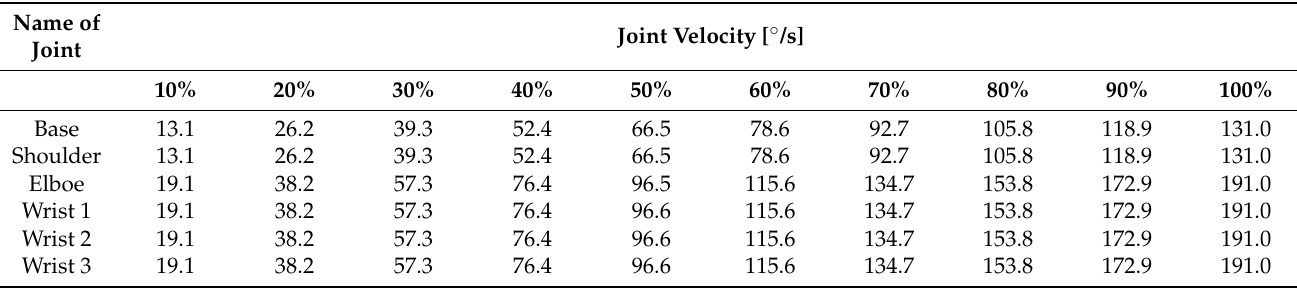
Table 1. Percentage velocities from maximum velocity for individual joints.